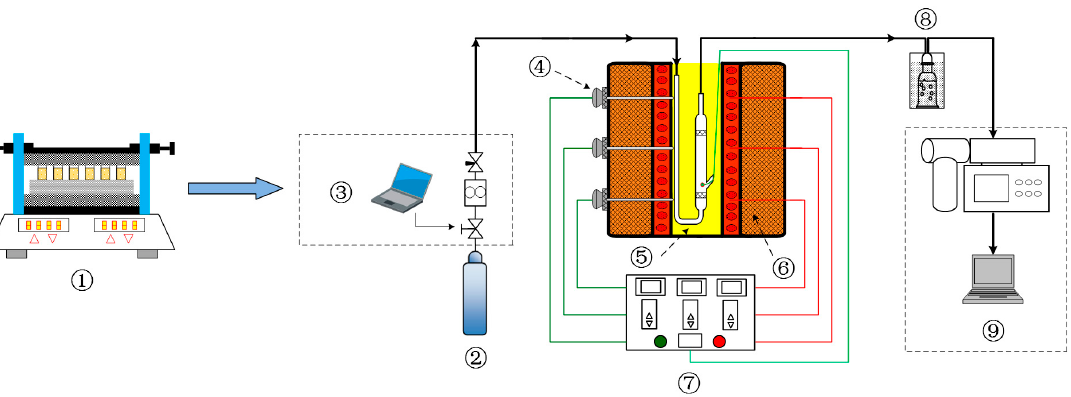
Figure 11. Schematic diagram of the experimental system: ① mechanical oscillator, ② Ar, ③ mass flow controller, ④ thermocouple, ⑤ reactor, ⑥ furnace, ⑦ temperature controller, ⑧ iced acetone bath, ⑨ mass spectrometer.